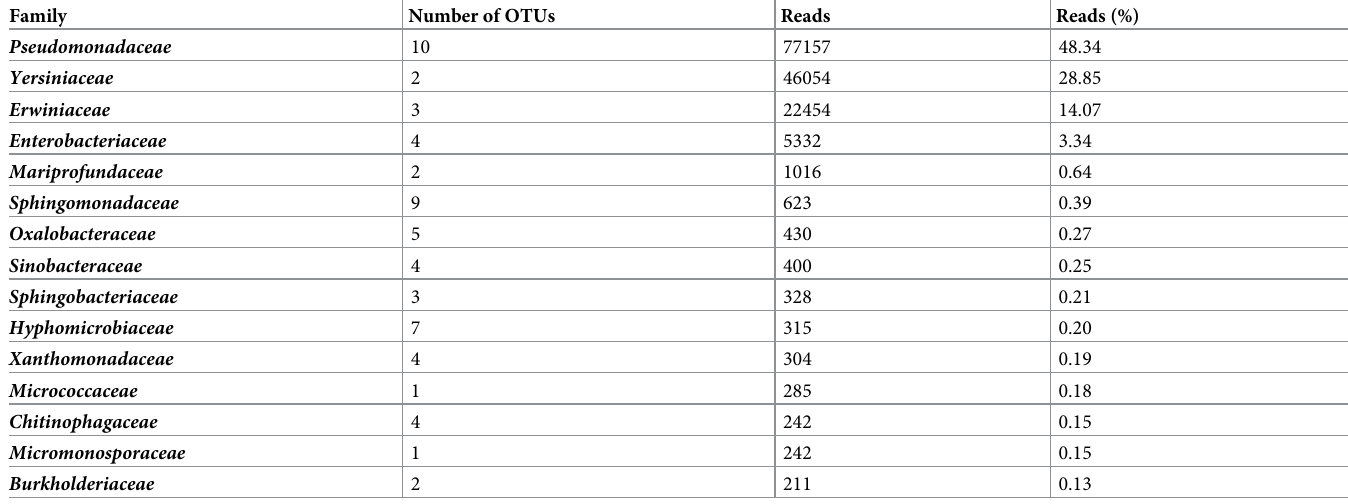
Table 1. Bacterial community composition in the mycosphere of S . commune presented as relative abundance (reads) and diversity (number of OTUs) at family level. Family Number of OTUs Reads Reads